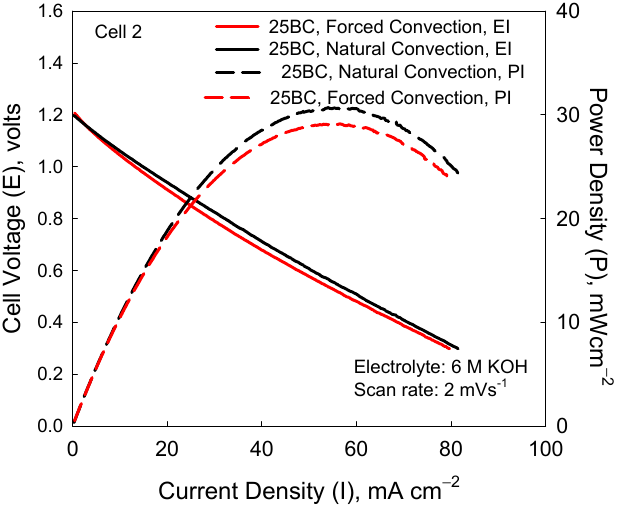
Figure 6. The E-I and P-I curves of Cell 2 with 25BC as ORR electrode under natural and forced air convection. 3.3. Cell 3 To eliminate the possible limitation of Pmax by the zinc electrode, in Cell 3, the size of the zinc electrode was increased. The E-I and P-I curves were measured for zinc elec- trode area/air electrode area ratios of 1:1 to 18:1. According to the results, Pmax increased as the anode/cathode area ratio was increased from 1:1 to 8:1. Figure 7a,b illustrate the E-